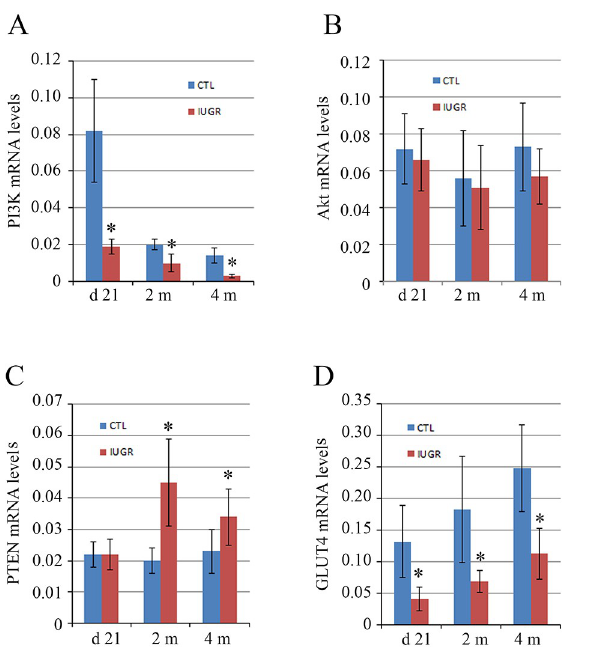
IUGR offsprings in comparison with the controls (Figs 2D and 3). This provided further evi- dence of insulin resistance in the IUGR offsprings. Peroxisome proliferator-activated receptor gamma (PPAR γ ), also known as the glitazone receptor, or NR1C3 (nuclear receptor subfamily 1, group C, member 3) is a type II nuclear receptor that in humans is encoded by the PPARG gene [29]. PPAR γ has the highest expres- sion levels in adipose tissue as compared with other metabolic organs, such as skeletal muscle, liver, and pancreas [30]. PPAR γ is the master regulator of adipogenesis, thereby stimulating the production of insulin-sensitive adipocytes [31]. In addition, PPAR γ activation in mature